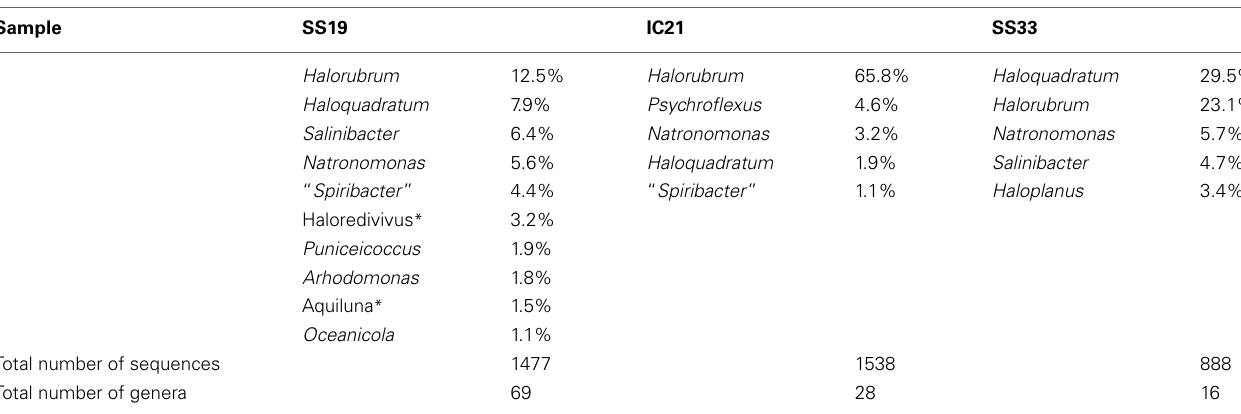
Table 2 | Microbial diversity at genus level in the metagenomic datasets SS19, IC21, and